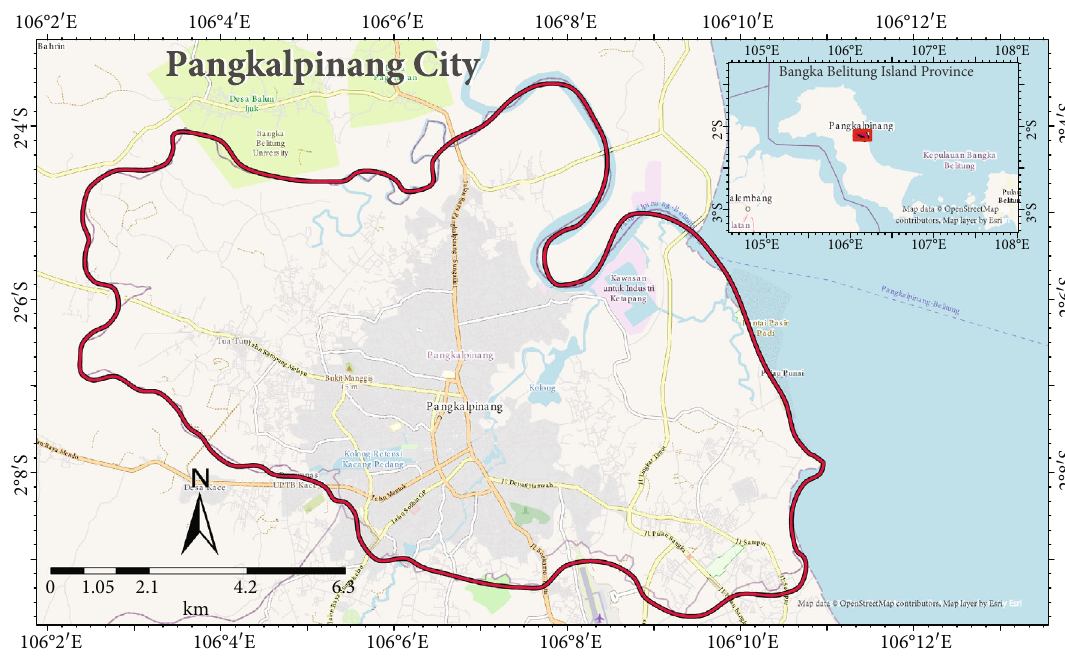
Figure 1: Pangkalpinang